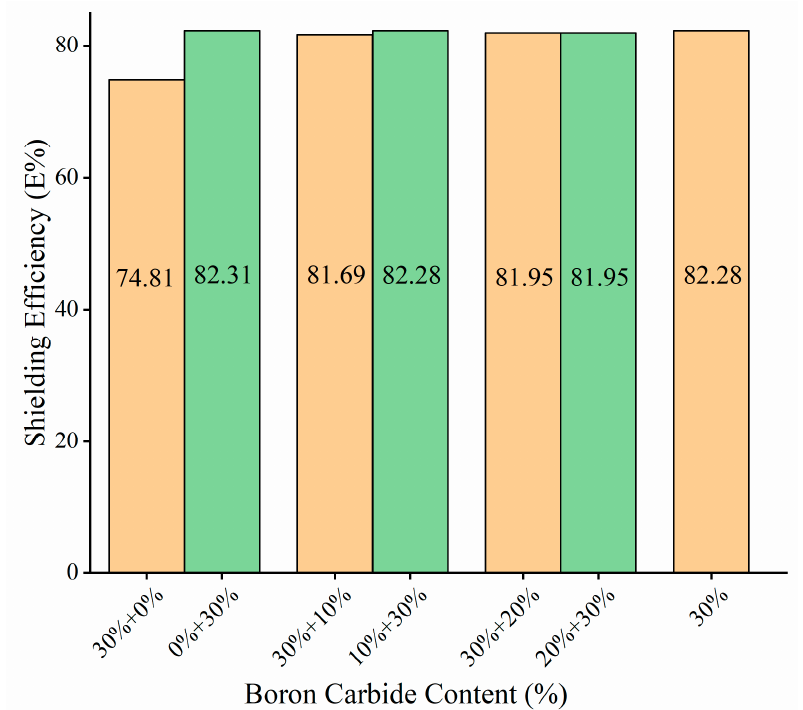
Figure 12. E ff ect of shielding performance of PEEK / boron carbide PEEK with special structure on the Am-Be neutron source. Note that the thickness of test pieces is 80 mm. “30% + 0%” means double-layer shielding body during testing. 30% wt. boron carbide PEEK material with 40 mm in thickness is close to the detector. Neat PEEK material thickness is 40